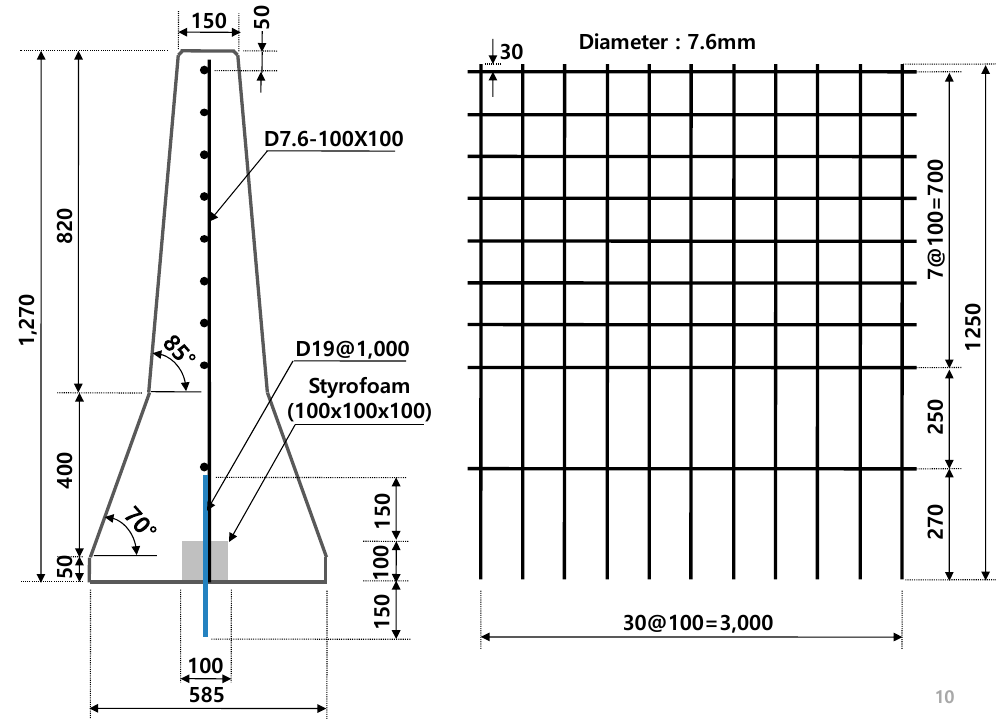
Figure 8. Proposed design of CMB-17S with a device allowing for deformation.